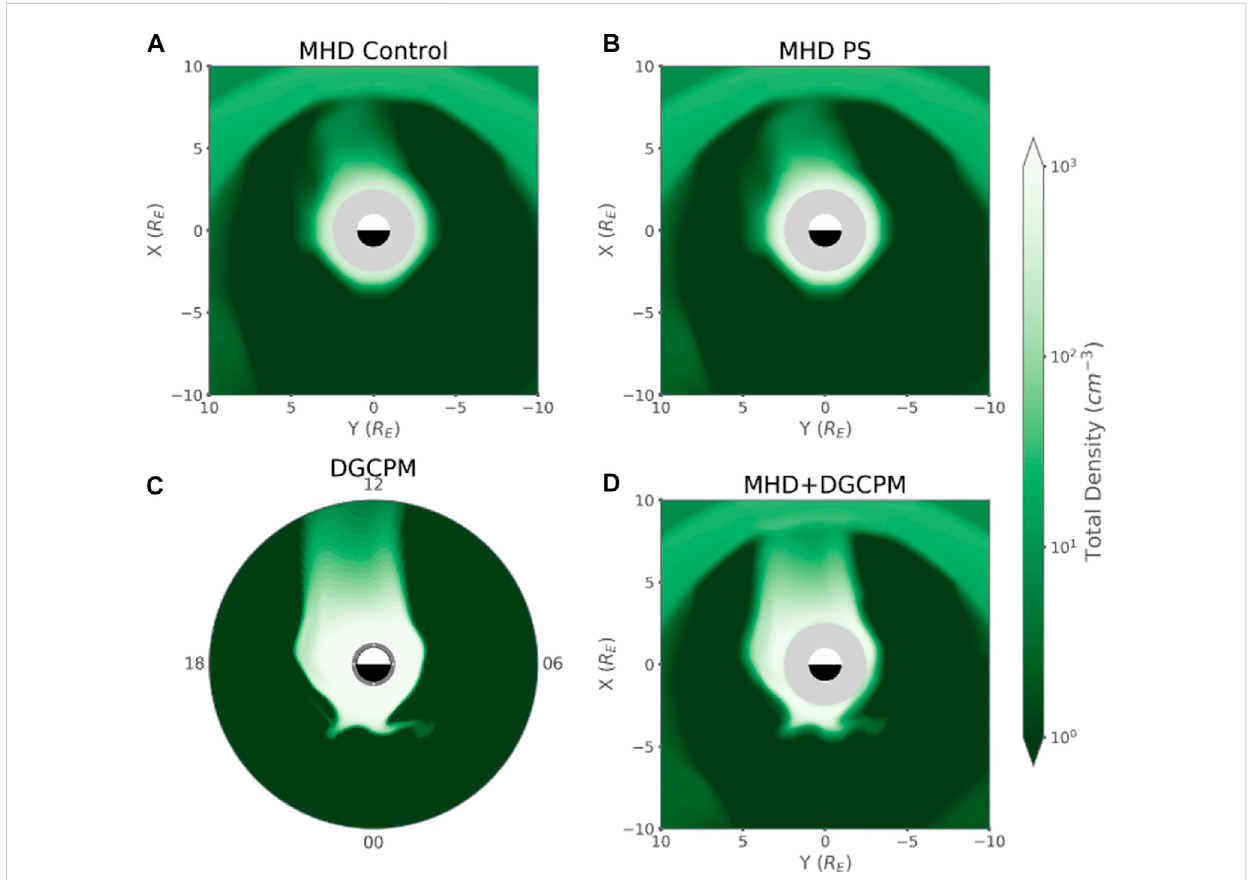
FIGURE 2 CouplingofBATS-R-USandDGCPM. (A) Z=0sliceofsingle fl uidBATS-R-USinstandalonemode.GSEcoordinates. (B) Z=0sliceoftwo fl uidBATS- R-US in standalone mode. GSE coordinates. (C) Standalone DGCPM out to 10 R E . LT and Radius (D) Z = 0 SWMF coupling dual fl uid BATS-R-US and DGCPM. GSE